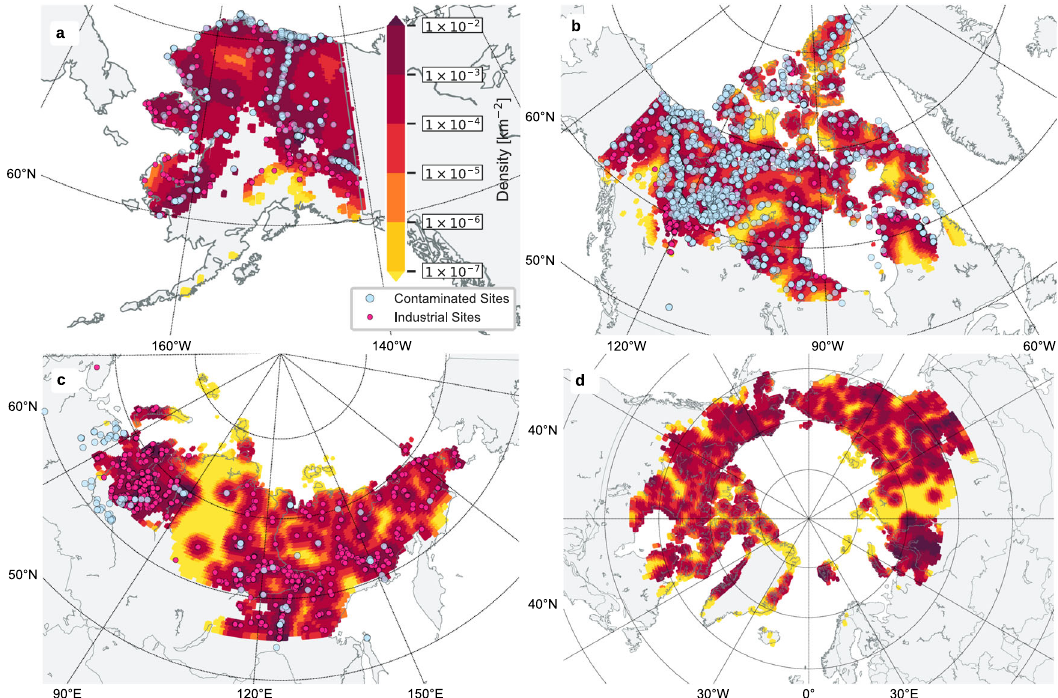
Fig. 5 | Projected densities of contaminated sites in Arctic permafrost domi- nated regions. The density maps of contaminated sites per area as derived by the pointprocessmodelsfor a Alaskaand b Canadawithdotsdepictingthelocationsof industrial and contaminated sites. Map c shows the predicted density of con- taminated sites for the permafrost dominated region in Russia with dots showing the data on contaminated sites surveyed in this study and that are used for model